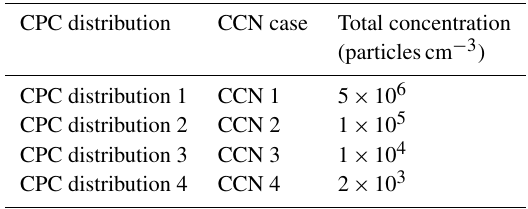
Table 5. Total concentrations used in theoretical aerosol distribu- tion for CPC operation at high concentration and CCN-derived κ app